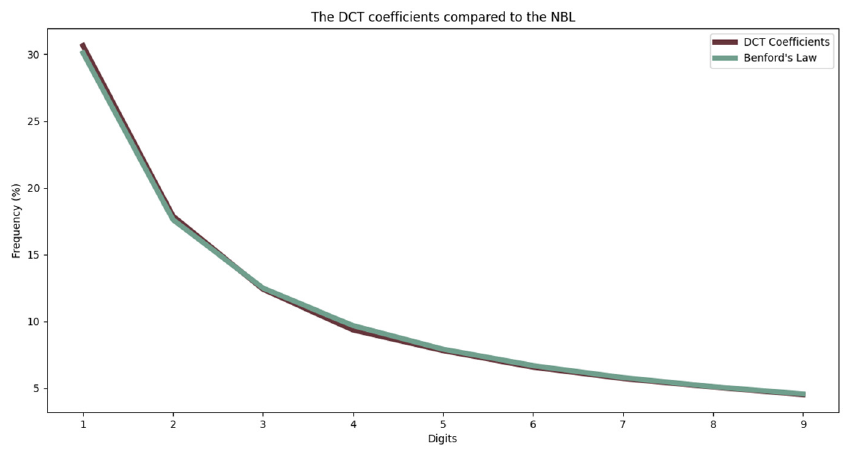
Figure 11. The DCT coefficients compared to the NBL for an uncompressed image.